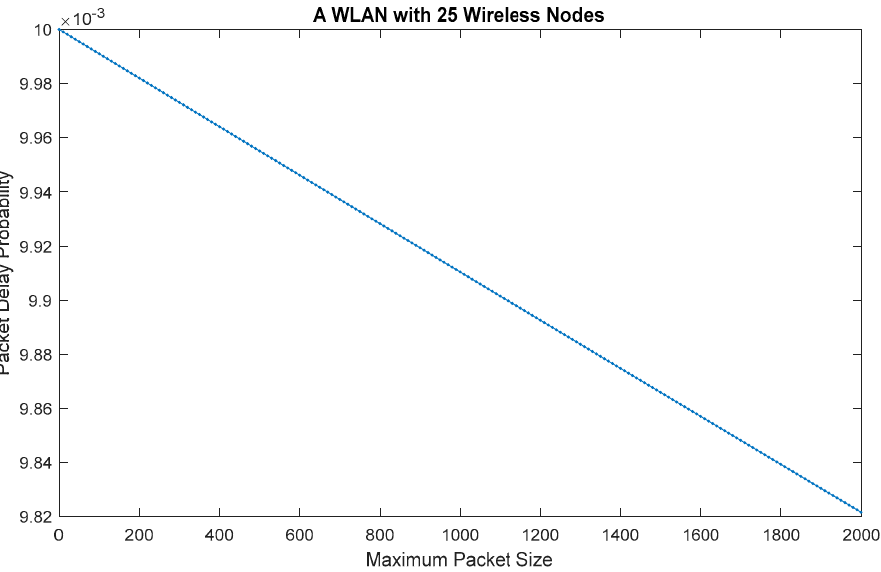
Figure 3. Data (packet) delay probability versus maximum packet size.